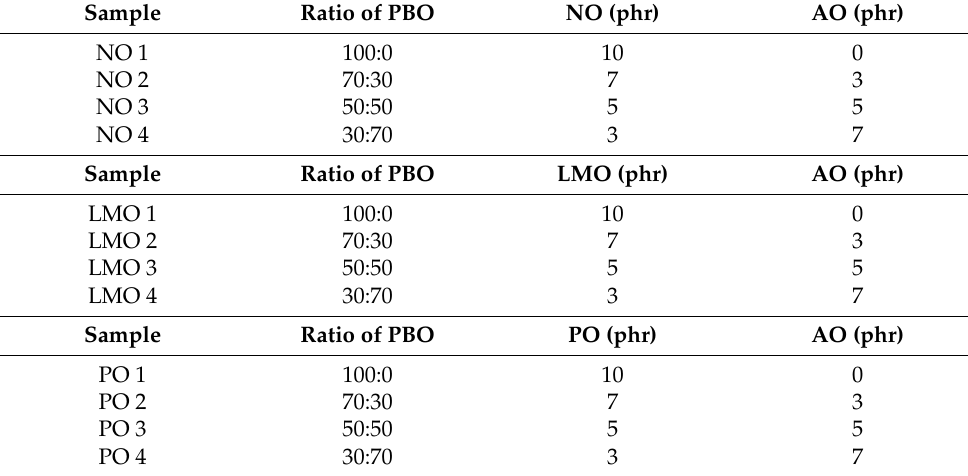
Table 2. Compound ingredients for different ratios of PBO.